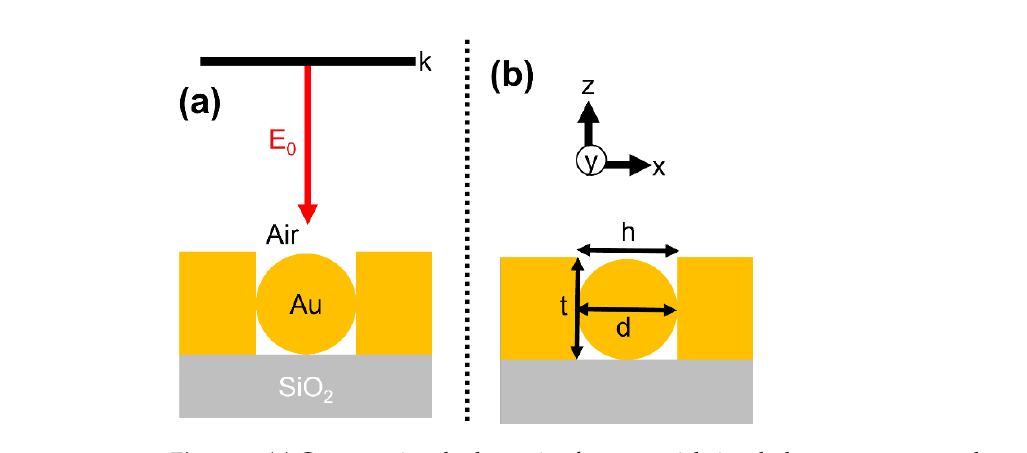
Figure 1. ( a ) Cross-sectional schematic of nanoparticle in a hole structure on a substrate describing simulation and material properties. A broadband plane-wave source with an incident electric field of E 0 is used to illuminate the nanostructure to understand its plasmonic properties. ( b ) Description of the nanostructure’s geometrical parameters.